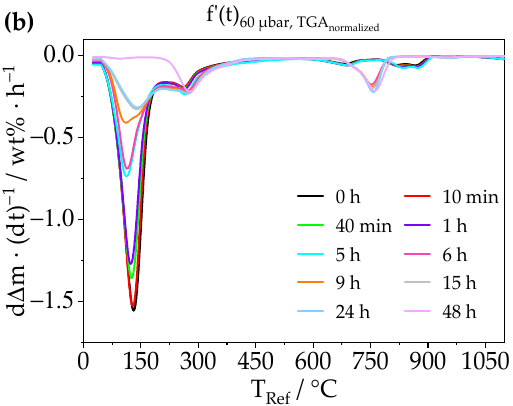
Figure 3. TGA data plotted as mass normalized time derived weight loss (d Δ m ∙ (dt) − 1 ) per hour against the reference temperature of synthetic ettringite with a heating rate of 5 °C/min after treatment at two different levels of low pressure ( a ) 4 mbar and ( b ) 60 µbar for various durations (up to 72 h); full time frame depicted in Figure S4.